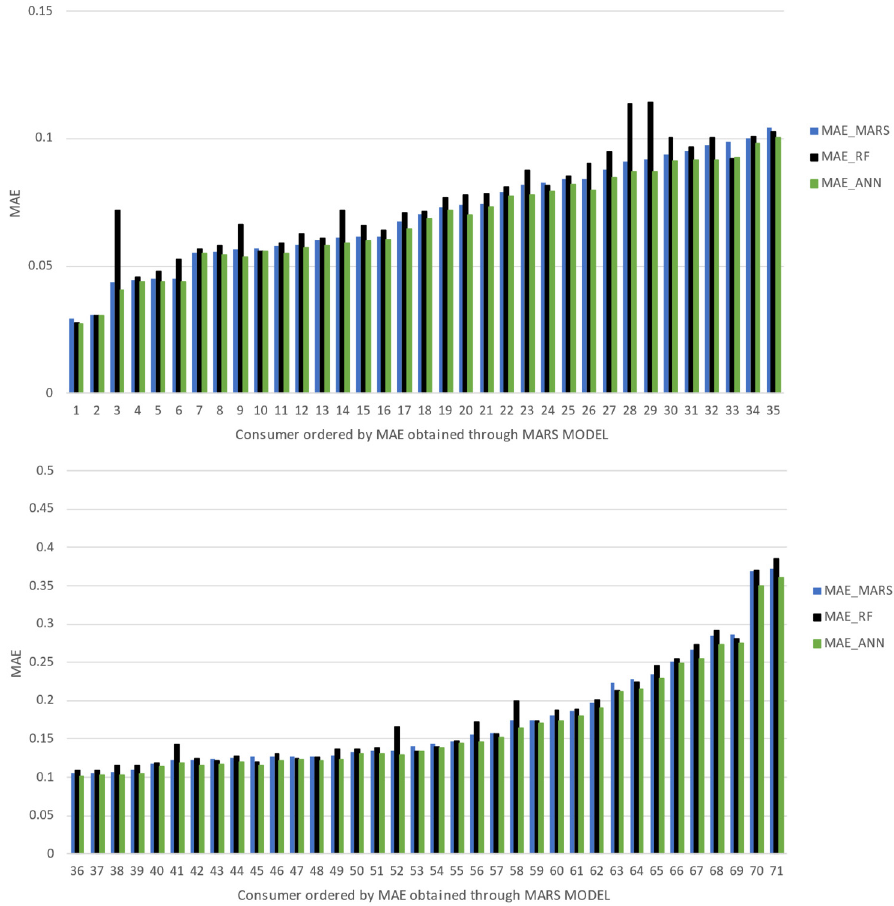
Figure 6. Bar charts involving MAE (in kWh) in an ascending order.